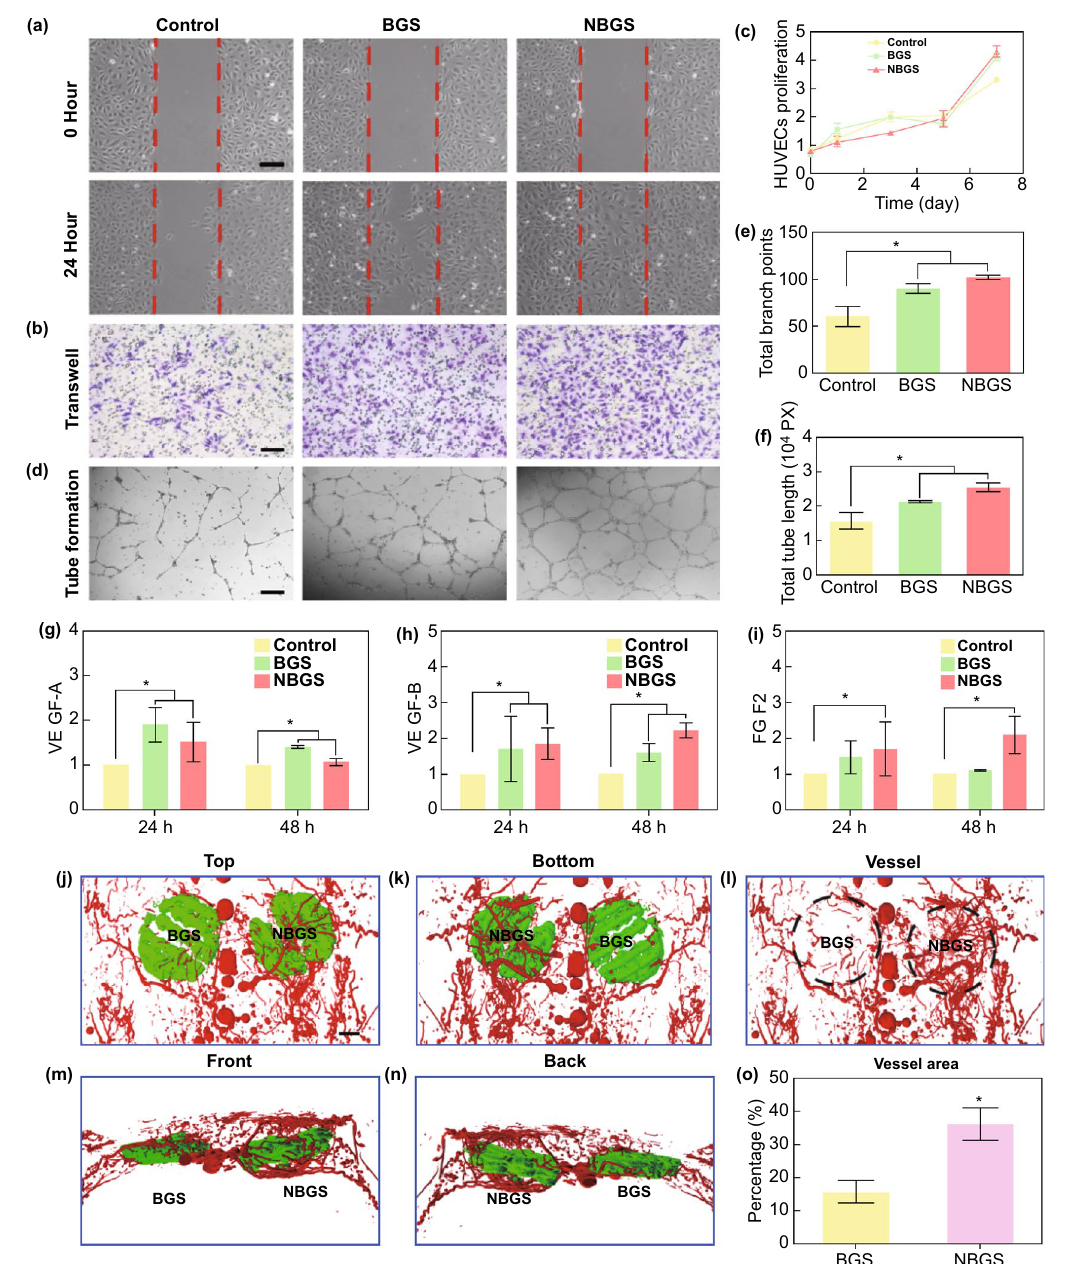
Fig. 4 Neovascularization stimulated by BGS and NBGS in vitro and in vivo. a Wound-healing assay using HUVECs cultured with BGS and NBGS for 24 h. b Proliferation of HUVECs cocultured with BGS/NBGS for 1, 3, 5 and 7 days. c Representative photomicrographs of tran- swell migration assay of HUVECs after 24 h. d Tube formation of HUVECs stimulated by BGS and NBGS for 24 h. e Quantitative analysis of total branch points. f Quantitative analysis of total tube length. g – i Vasculogenesis-related gene expression ( VEGF-A , VEGF-B and FGF2 ) in HUVECs cultured with different scaffolds after 24 and 48 h. j–n Reconstructed 3D micro-CT images of the blood vessels (red) surrounding the scaffolds (green) at 3 weeks. o Quantitative analysis of newborn blood vessels. The scale bar represents 250 μm ( a – c ) and 1 cm ( j – n ). (Color figure